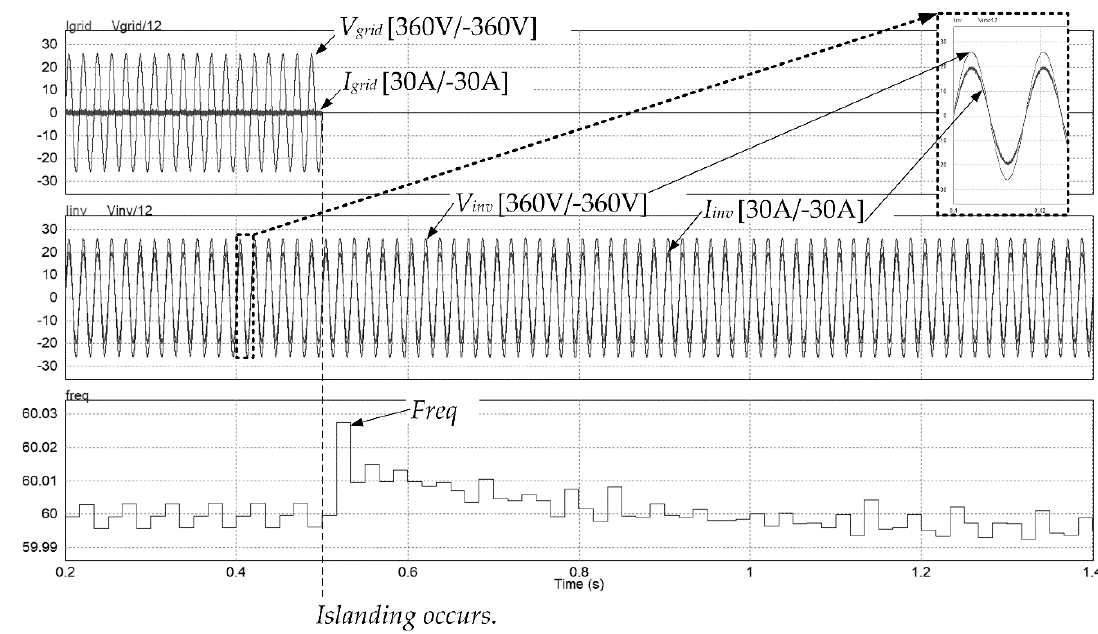
Figure 6. Simulation circuit for islanding test.